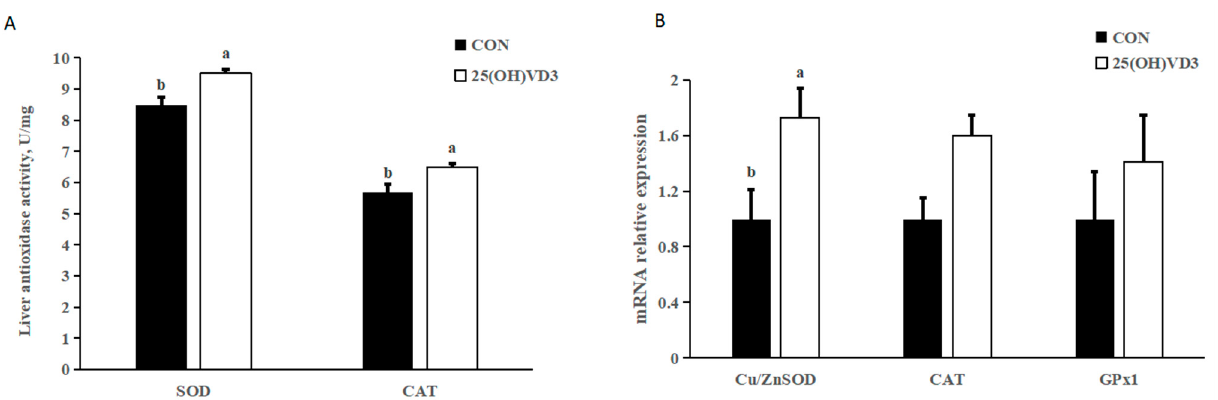
Figure 2. Effects of 50 µ g/kg 25(OH)VD 3 on antioxidase activity in the liver of growing-finishing